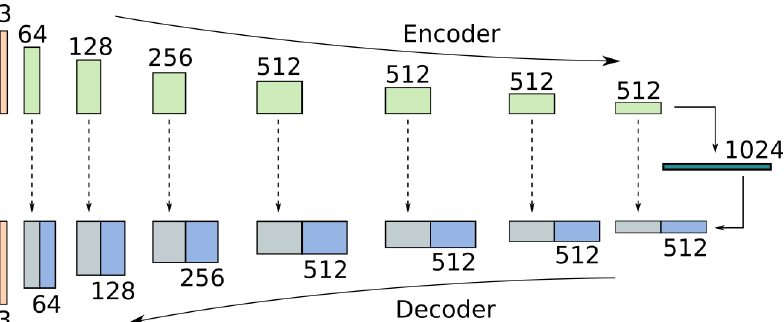
Figure 1. Network architecture based on the UNet architecture [26] with skip connections.